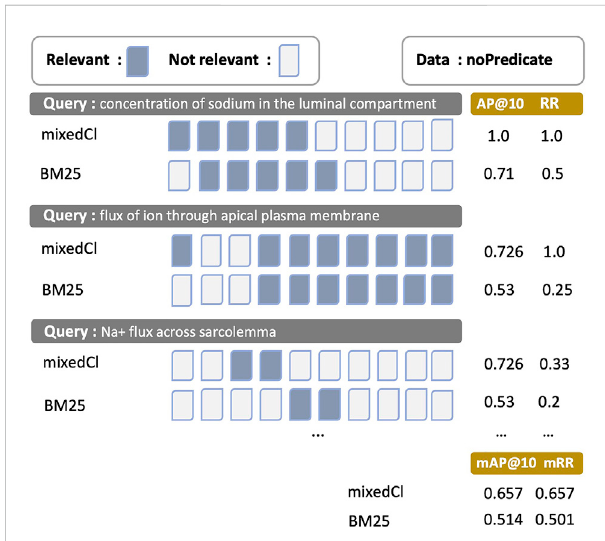
FIGURE 5 The presentation of search results differentiated by mAP@ 10 and mRR towards values. Blue boxes are relevant entities, while white boxes are irrelevant entities. mAP@ 10 and mRR are calculated from theresultsofthe mixedCl andBM25methodsonthe noPredicate query-entity pair set. Results are sorted in which entities with the higher similarity to the query are placed on the left-hand side. The results of the fi rst and third queries are similar for both methods, but the use of mixedCl , with higher mAP@ 10 and mRR , can show relevant entities earlier than